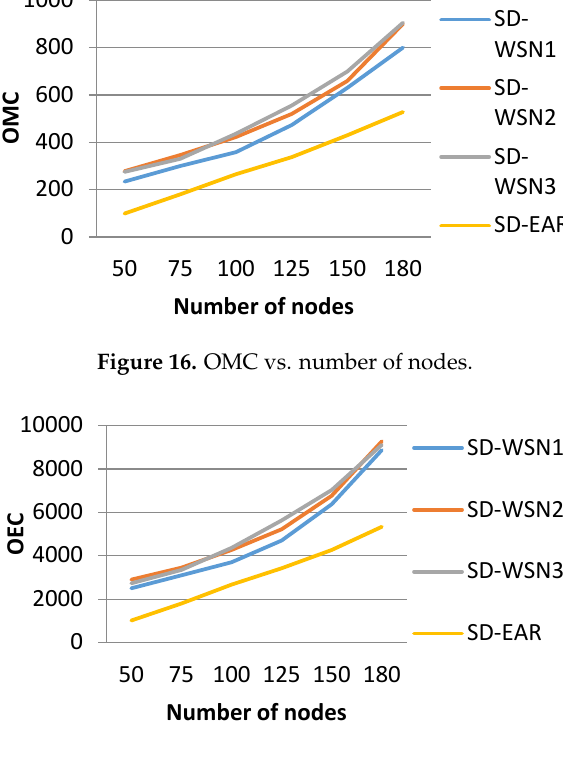
Figure 15. Percentage of alive nodes per established communication session (PALC) vs. number of nodes.